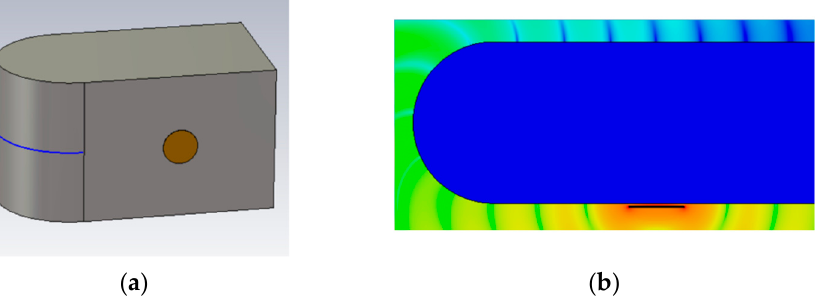
Figure 14. The model used for the surface and creeping wave simulation: ( a ) front sight; ( b ) the electric field distribution (top view).